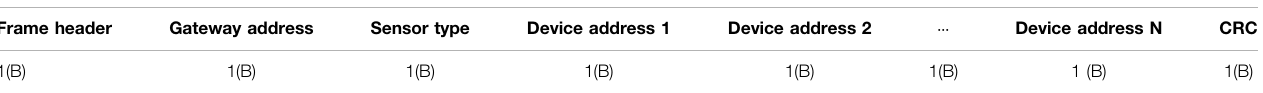
TABLE 2 | Frame structure of the issued command.